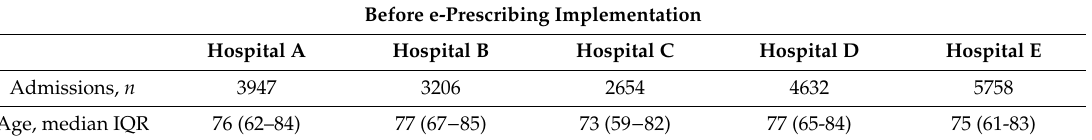
Table 1. Study sample characteristics (total admissions: 43220; years